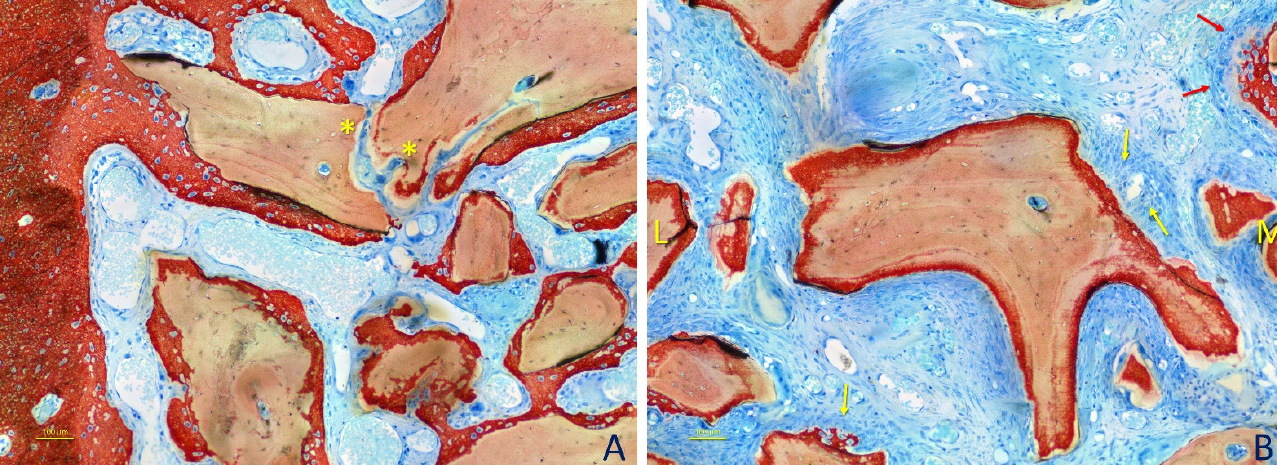
Figure 6. Photomicrographs of ground sections representing the healing after 4 weeks at large granules sites. ( A ) Bone walls region. Higher content of new bone was found compared with the previous period analyzed. Some multicellular cells were still visible (e.g., *). ( B ) New bone reached over time the most central regions, growing from the lateral (L) and mesial (M) bone walls of the sinus. The granule in the center presents a higher peripheral chromaticity compared with that seen in the previous period of healing. Moreover, some of the dense tissue surrounding the granule appeared to have a higher content of active cells, especially in zones where the new bone was formed between the graft surface and the cellular cluster (yellow arrows). Note a front of new bone formation and osteoid tissue (red arrows). Original magnification × 200. Stevenel’s blue and alizarin red stain.